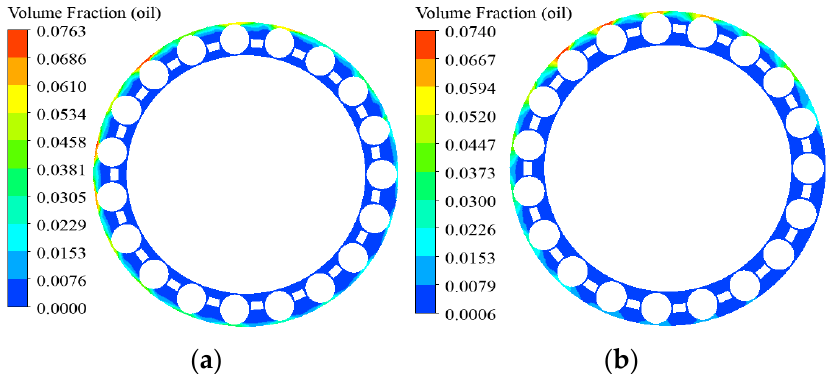
Figure 16. Lubricating oil distribution at the center sections of the bearing large rollers. ( a ) Outer ring rib structure; ( b ) Inner ring rib structure.